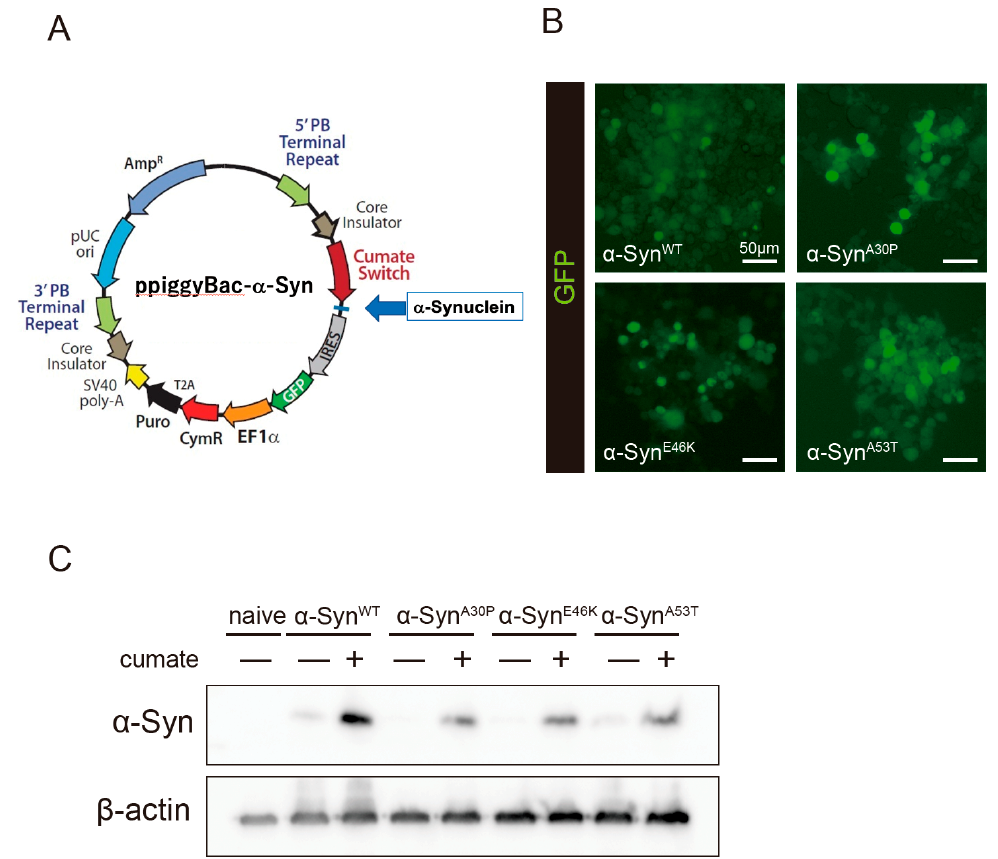
Figure 1. Establishment of a cumate-induced α -Syn expression system. ( A ) PiggyBac cumate- α -Syn transgene vector. ( B ) Confocal imaging of GFP in α -Syn-N2a cells, which were cotransfected with the piggyBac cumate- α -Syn transgene vector and piggyBac transposase construct after exposure to 50 µg/mL of cumate for 48 h. Scale bar: 50 µm. ( C ) Immunoblot analysis of α -Syn protein levels after exposure to 50 µg/mL of cumate for 48 h.